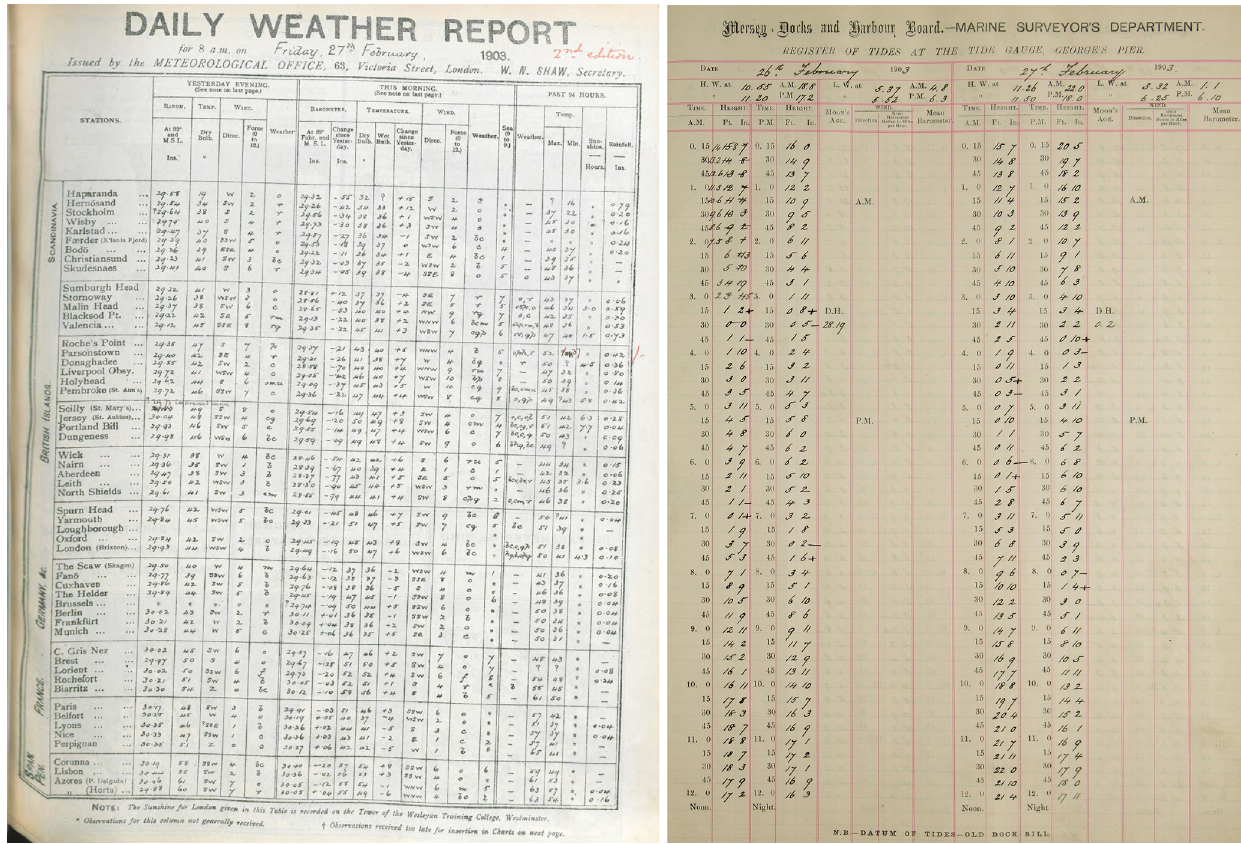
Figure A1. The UK Daily Weather Report observations page for 27 February 1903 (left; from NMLA, 2023) and tide gauge measurements from Liverpool Docks for 26–27 February 1903 (right; supplied by